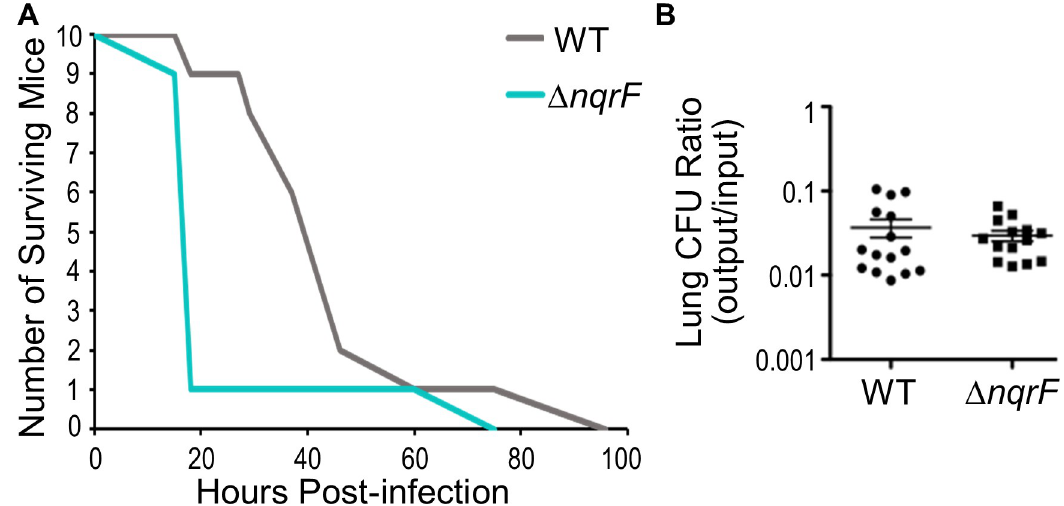
Fig 8. Survival of mice infected with wild type PAO1 and Δ nqr . A. Survival of BALB/c mice after intranasal aspiration of ~4 x10 6 CFU wild type or Δ nqrF . The survival curves were statistically different (p < 0.05; log rank test). B. Bacterial burden in the lungs. Lungs were harvested from mice infected with ~5–6 x 10 5 CFU at 24 h post-infection, and the ratio of CFUs before inoculation and after death were counted. There is no significant difference between the bacterial burden from wild type PAO1 and Δ nqrF . (This is representative of two independent